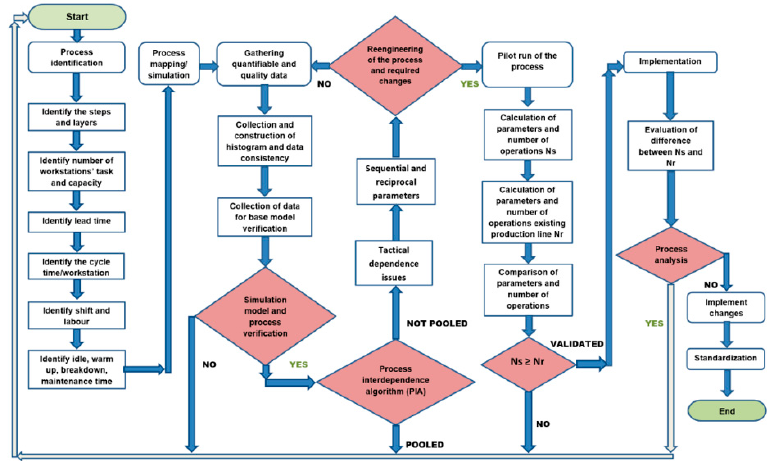
Figure 1. Proposed Khan–Hassan–Butt (KHB) methodology.